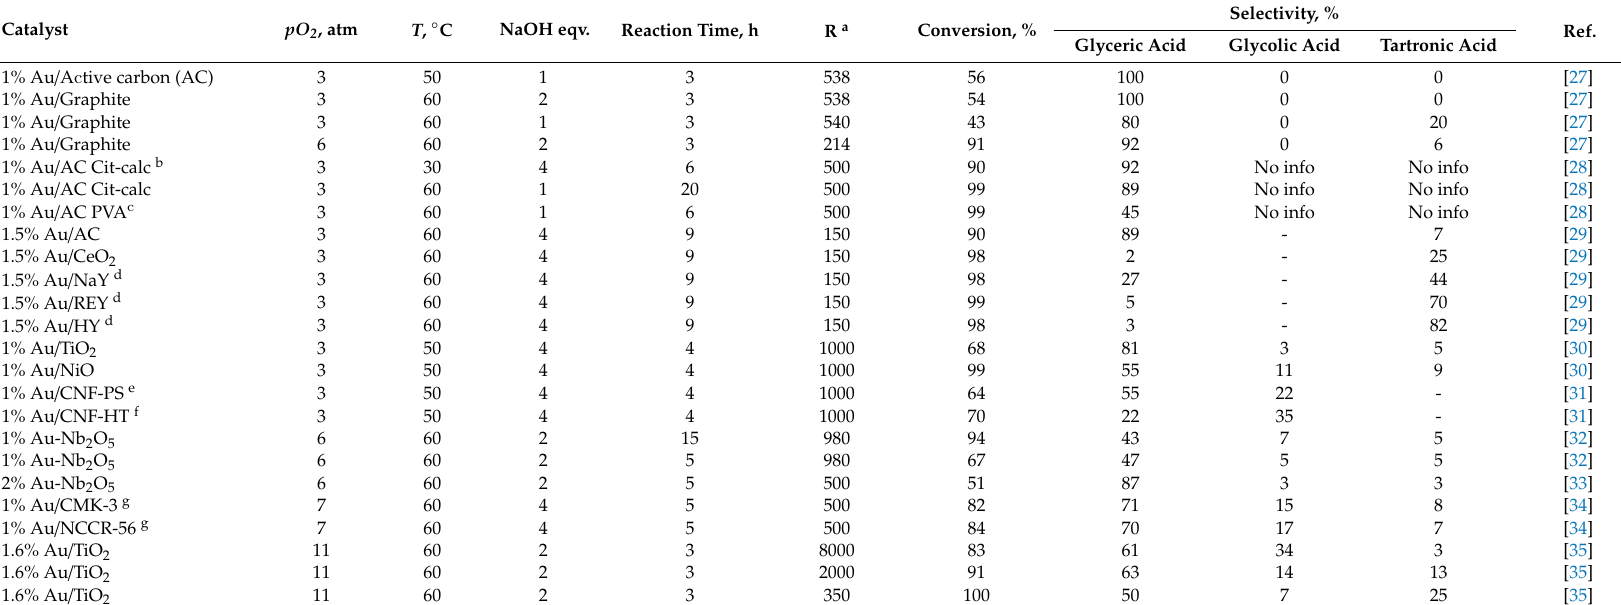
Table 1. Catalytic oxidation of glycerol on gold catalysts under basic conditions using O 2 as an oxidant and H 2 O as a